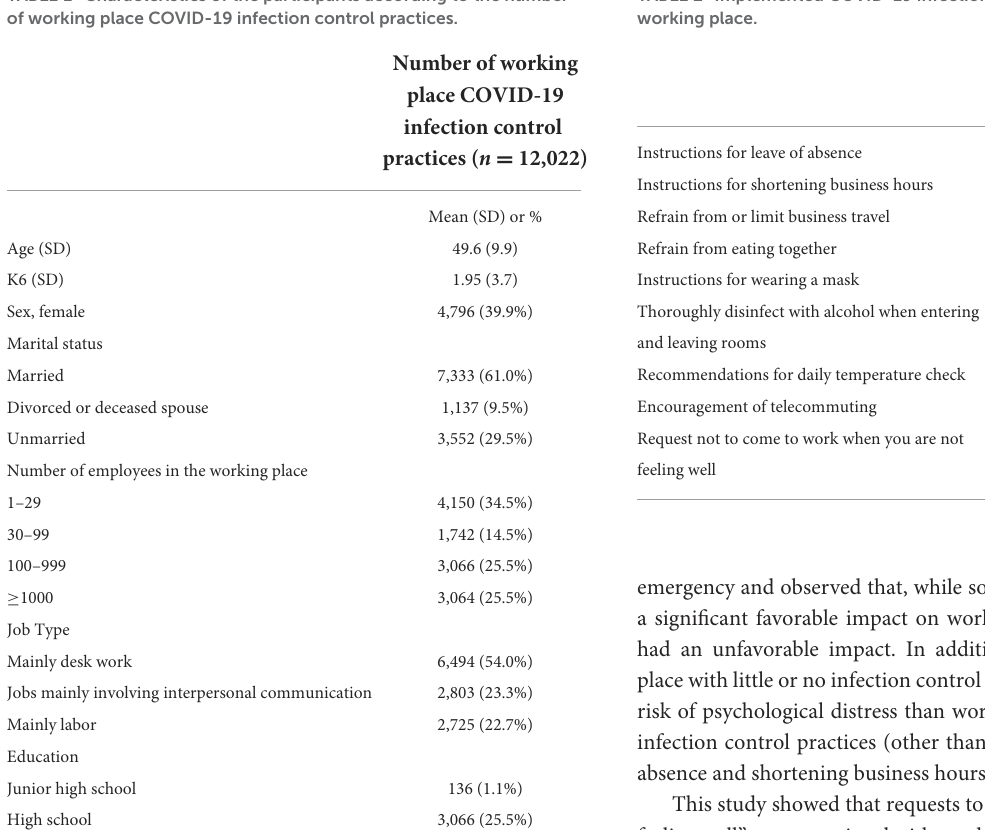
TABLE 1 Characteristics of the participants according to the number of working place COVID-19 infection control practices.